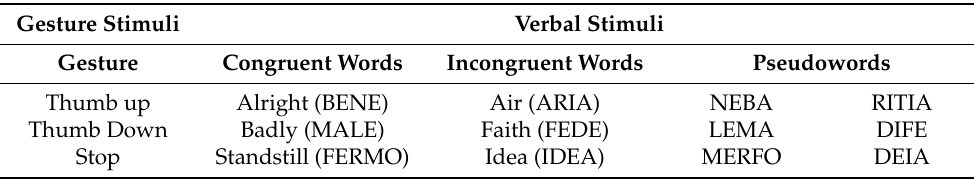
Table 1. Gestures and words (translated into English) presented in the experiment. The words in Italian are presented in